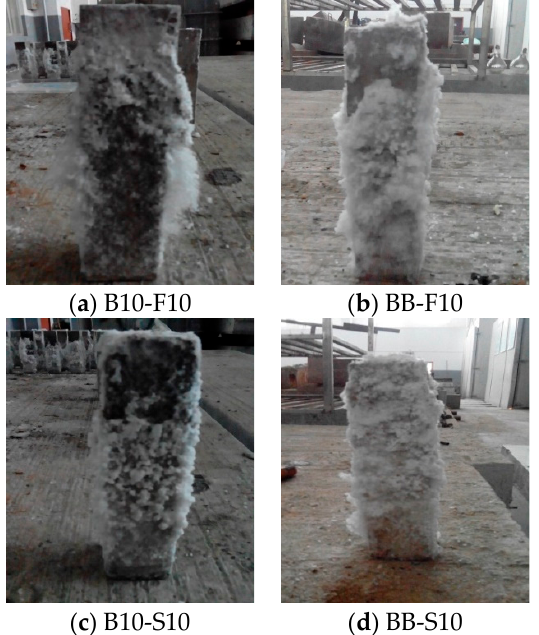
Figure 11. Crystallization on the surface of the mortar containing fly ash and slag attacked by semi- immersion form.